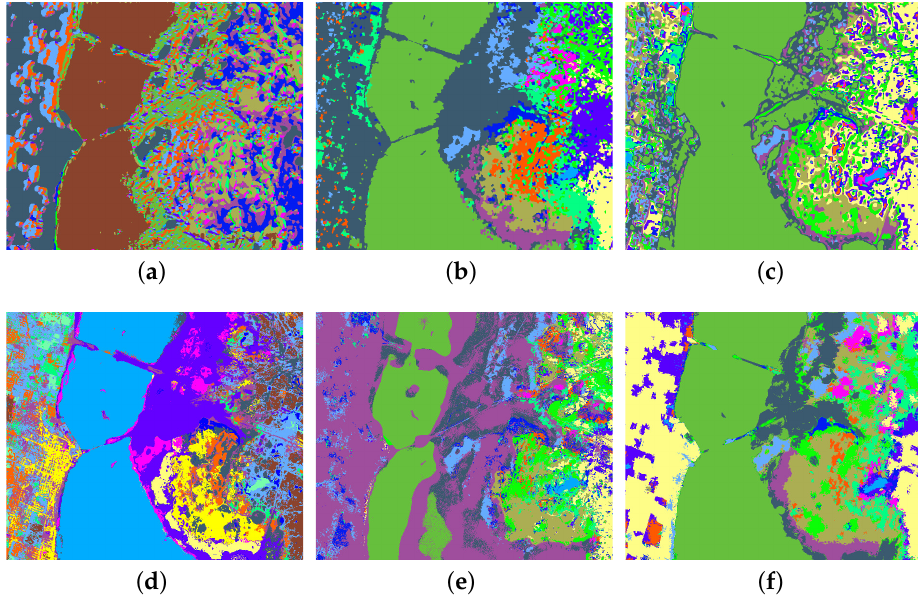
Figure 16. Classification maps for the Center of KSC data set using different methods. ( a ) HybridSN;